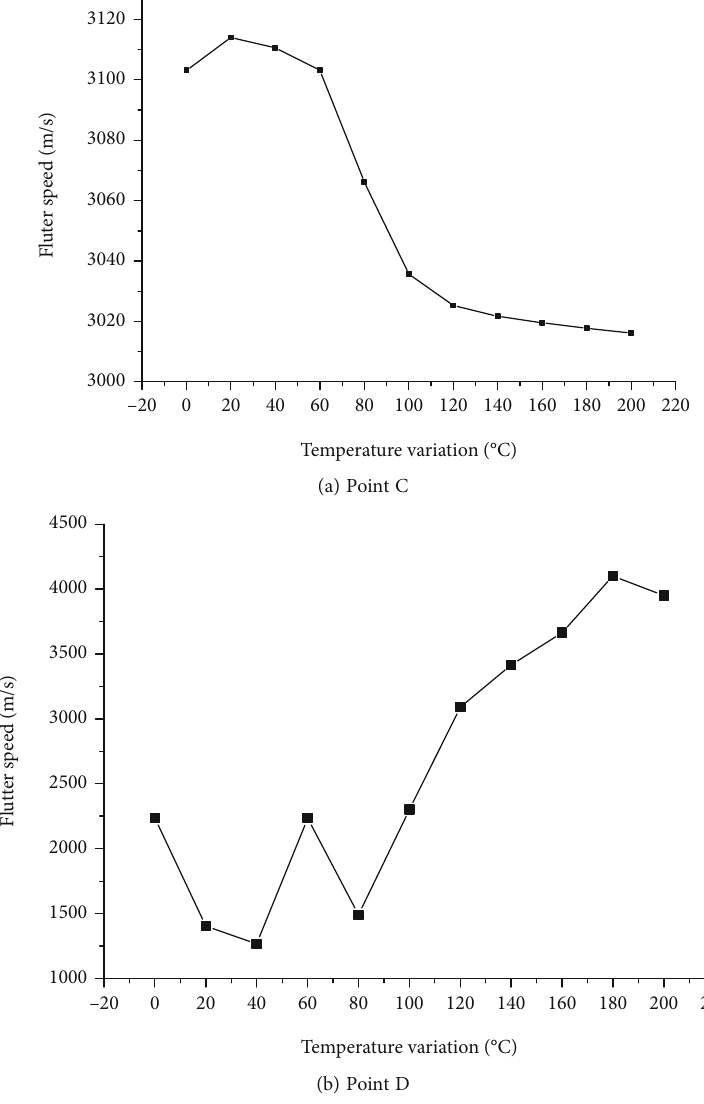
Figure 16: Flutter change curve with temperature